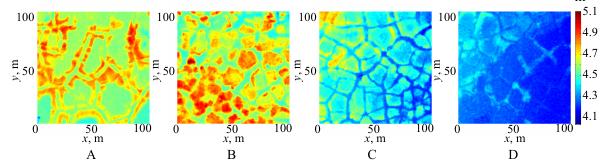
Figure 1. DEM for site A, B, C, and D. The spatial extent of each site is 104m × 104m.